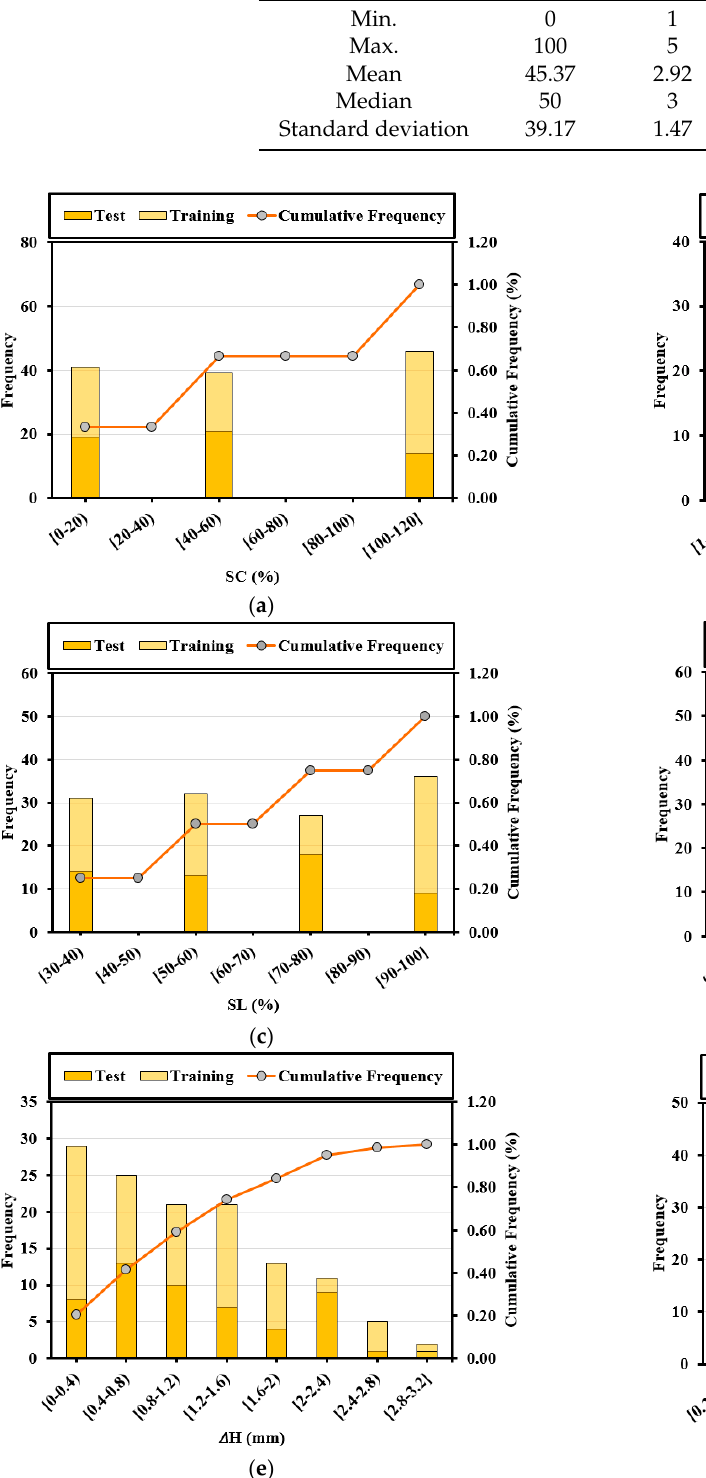
Figure 2. The frequency and cumulative frequency histograms, along with the statistical features, of the input and output data. ( a ) SC, ( b ) 𝜎 (cid:3041) , ( c ) SL, ( d ) Dr, ( e ) ∆ H, ( f ) CSR. Table 1. Statistical features of training data.